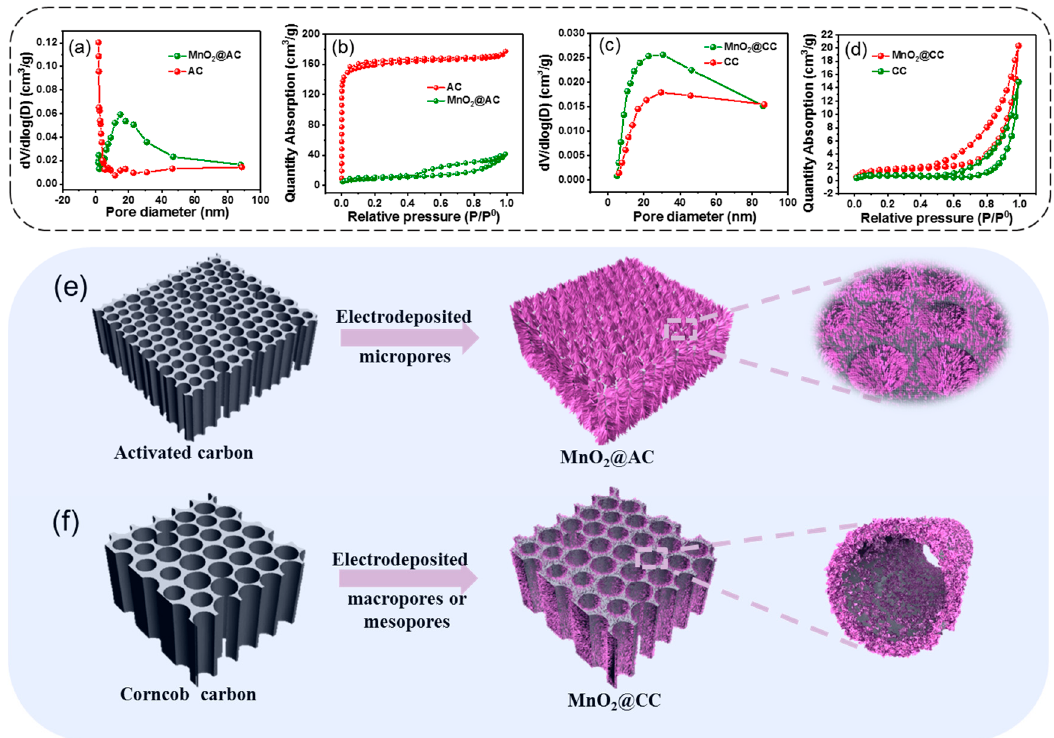
Figure 2. ( a , c ) The pore size distribution curves of AC and CC, respectively. ( b , d ) Nitrogen adsorption–desorption isotherms of MnO 2 @AC and MnO 2 @CC, respectively. ( e , f ) Schematic illustration depicting the architecture of AC and CC with electrodeposited MnO 2 ,